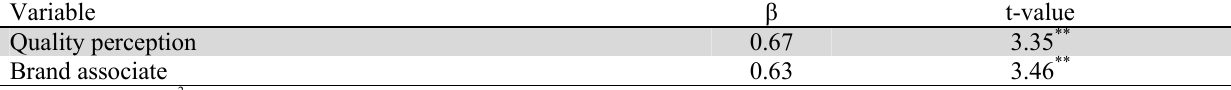
The results of the effects independent variables with brand loyalty as dependent variable Variable